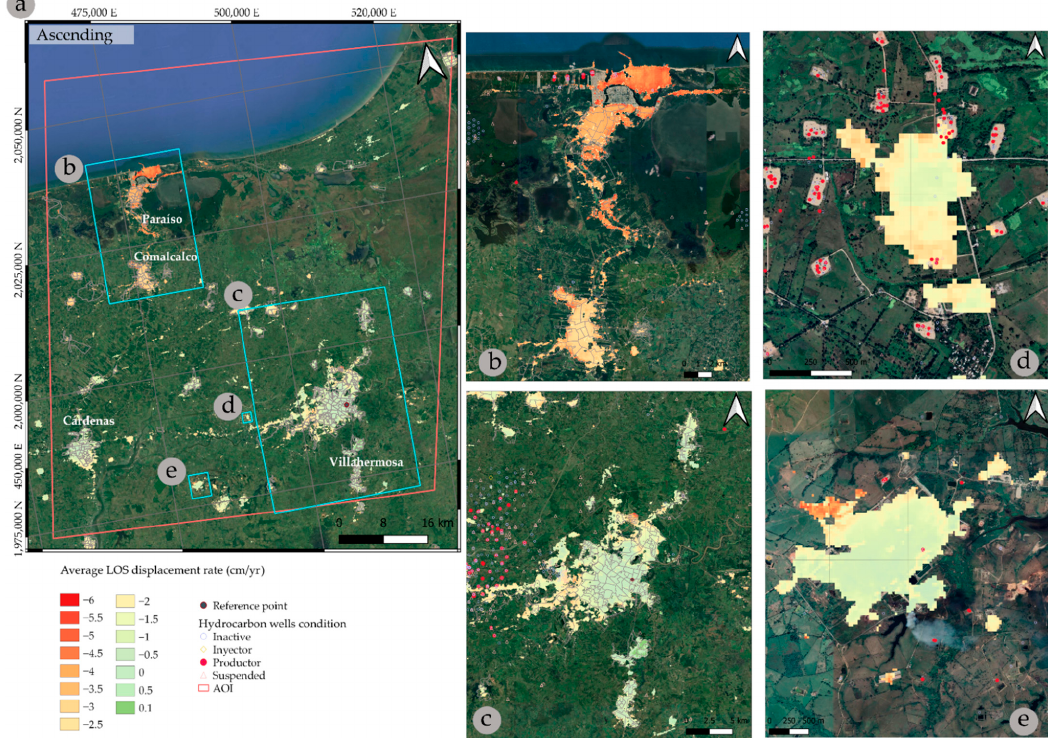
Figure 12. Map of average LOS displacement rates (cm/yr) obtained through the DIS approach, using the Sentinel-1 SLC images of ascending orbital pass acquired in the 2018 − 2019 period. Negative values indicate a movement away the satellite, ( a ) full AOI map. Blue rectangles enclose the zones with a higher average LOS displacement rate. Close-ups of the ( b ) Paraíso and Comalcalco; ( c ) Villahermosa; ( d ) Batería Samaria and ( e ) Batería Cactus zones are presented. The location of hydrocarbon wells is also shown.